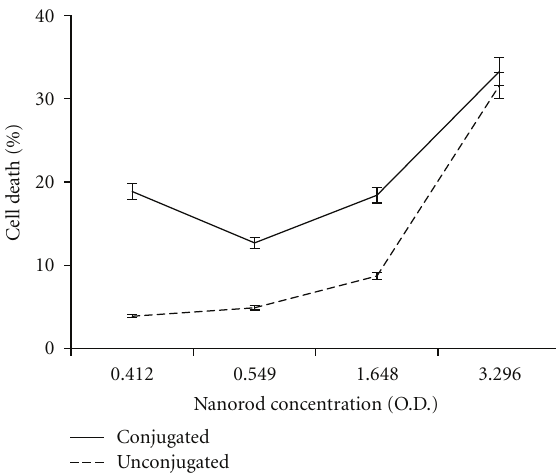
Figure 5: This cell viability assay shows the percentage of cell death of conjugated (solid line) and unconjugated (dashed line) nanorods after photothermal therapy with increasing nanorod concentration after three